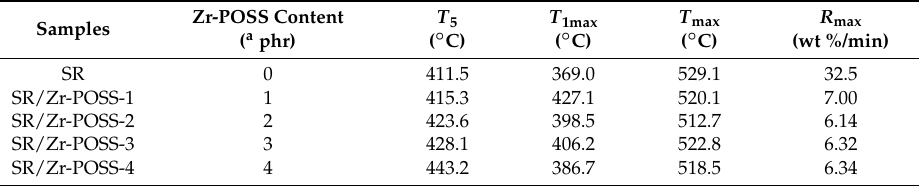
Figure 7. TGA and DTG curves of SR/Zr-POSS nanocomposites under air atmosphere. Table 1. Characteristic data obtained from TGA and DTG curves (air, 20 ◦